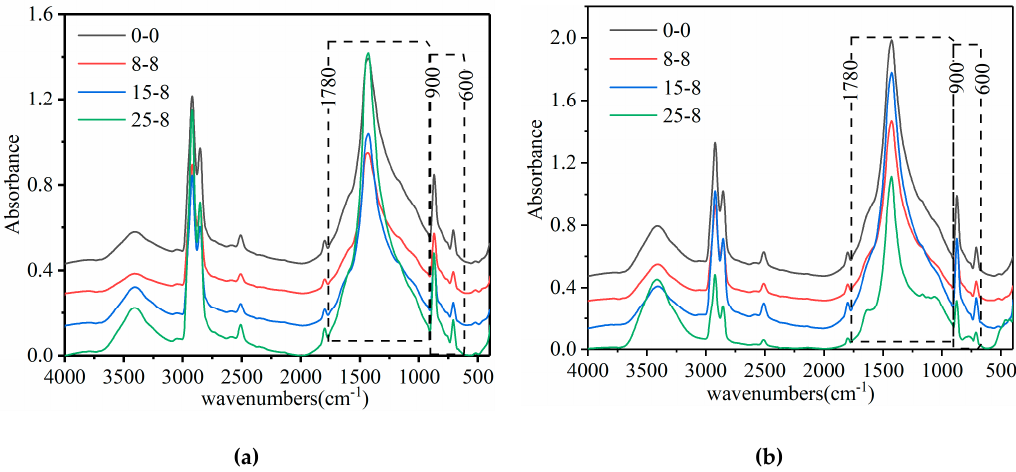
Figure 7. FTIR spectra of mastics in different test conditions. ( a ) Base mastics; ( b ) SBS-modified mastics.